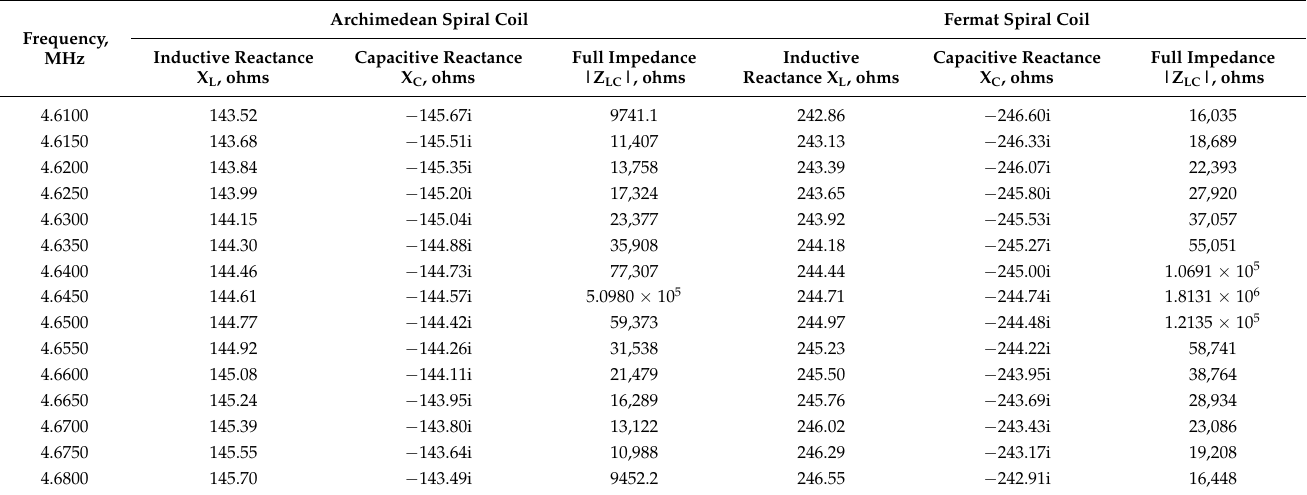
Table 3. The results of analysis of the frequency dependences of the impedance of the elements of oscillatory circuits used in the study of the numerical models of Fermat spiral coil and Archimedean spiral coil.